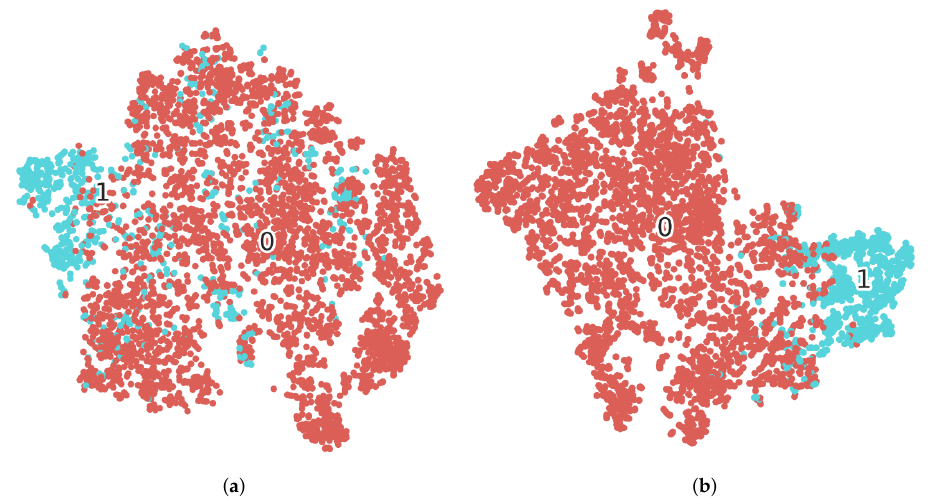
Figure 10. Feature visualization with t-SNE. ( a ) Visualization of features without deep supervision. ( b ) Visualization of features with deep supervision. Dots in red and marked with 0 represent unchanged features. Dots in blue and marked with 1 represent changed